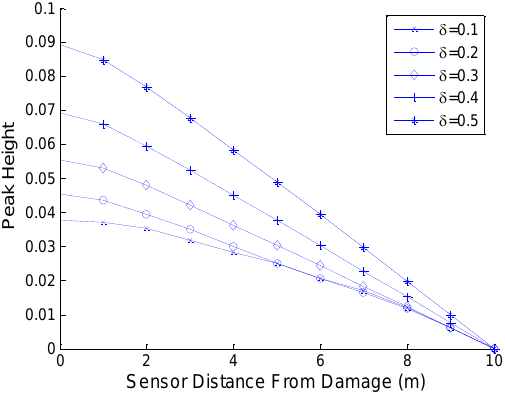
Fig. 11. Maximum damage peak height versus distance of sensor from damage